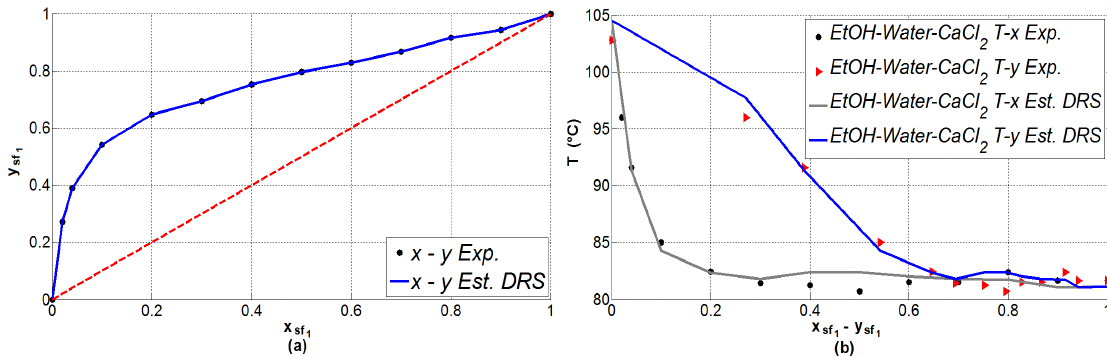
Figure 3. VLE of ethanol–water-CaCl 2 system, expressed on a salt-free basis. ( a ) xy diagram; ( b ) Txy diagram. Table 2. Experimental ( y sf ,1, Exp and T Exp ) and estimated ( y sf ,1, Est and T Est ) VLE data of